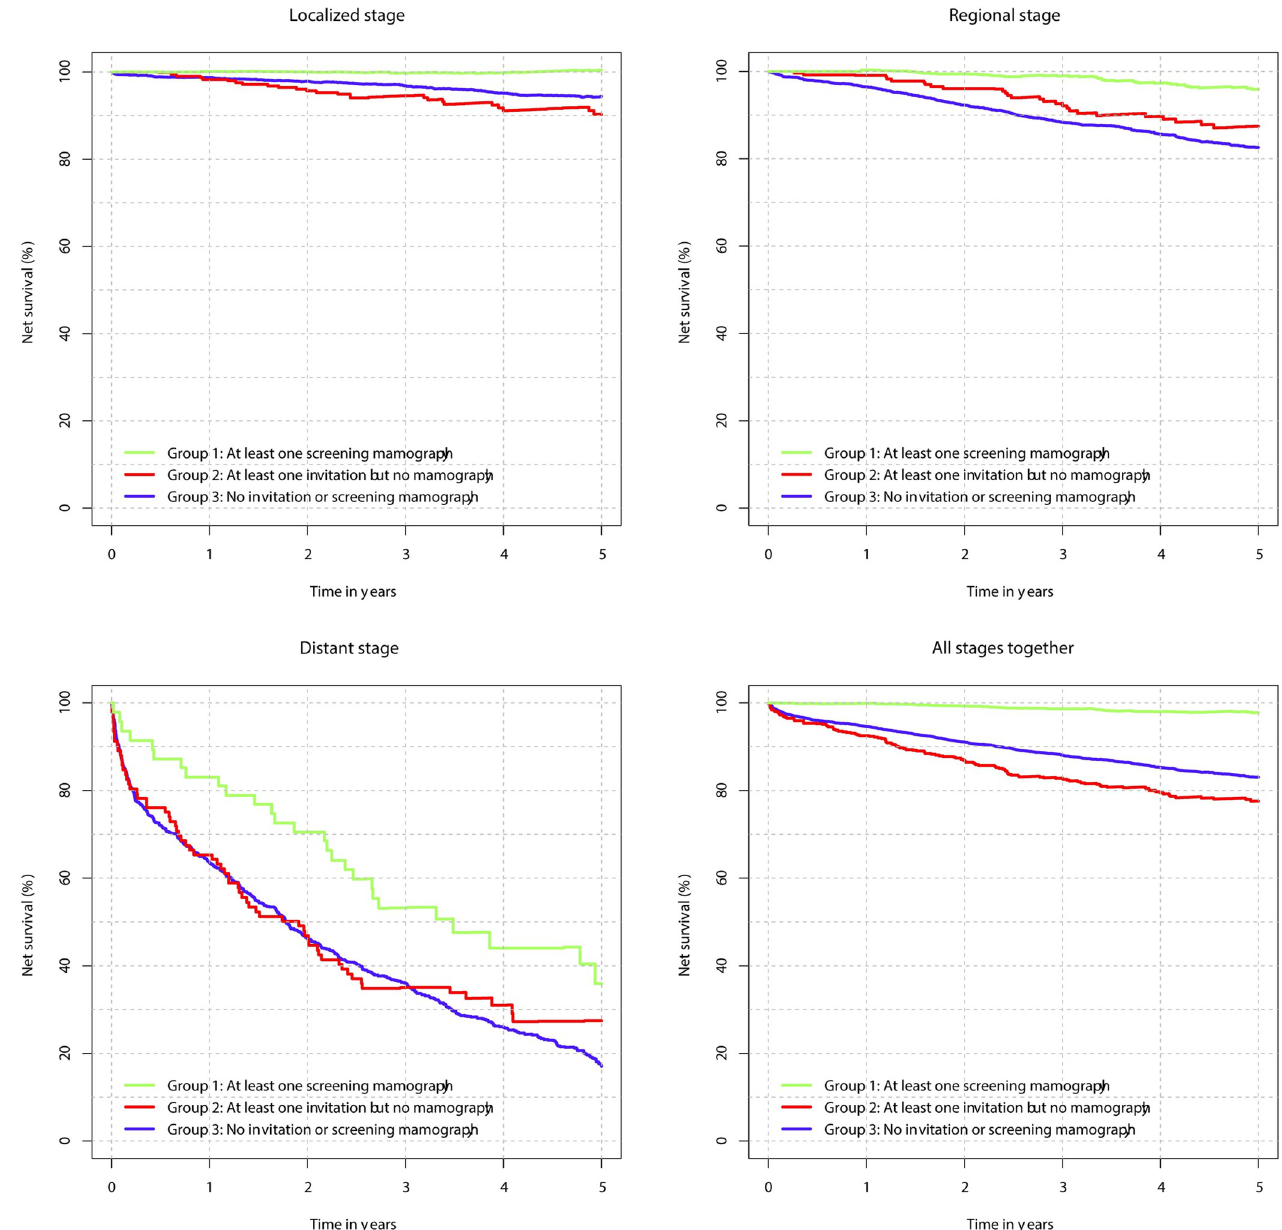
Fig 3. Five-year net survival for women with breast cancer according to stage and screening program status, Slovenia 2008–2018.